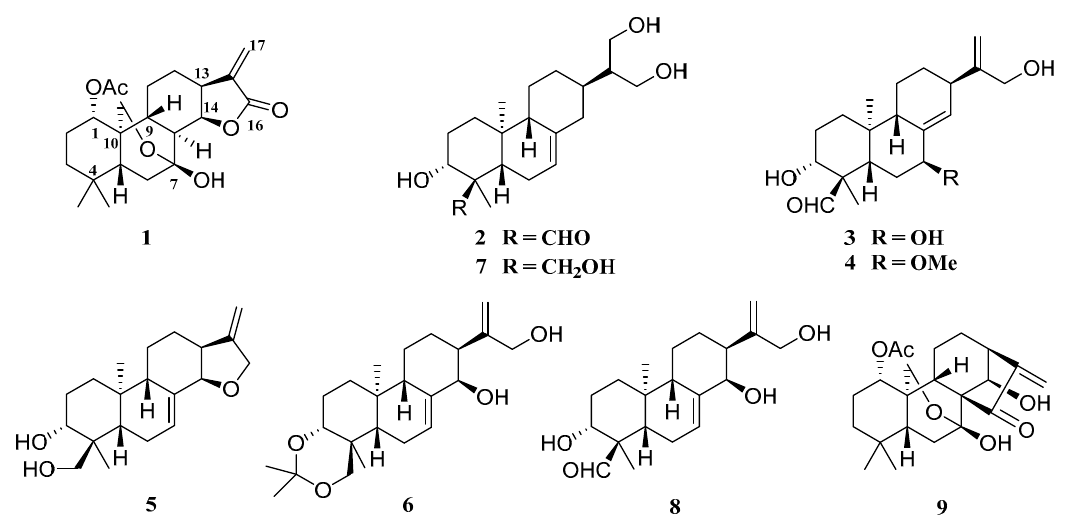
Figure 1. Ent -abietanoids ( 1 – 8 ) isolated from Isodon serra and rabdocoestin B ( 9 ).